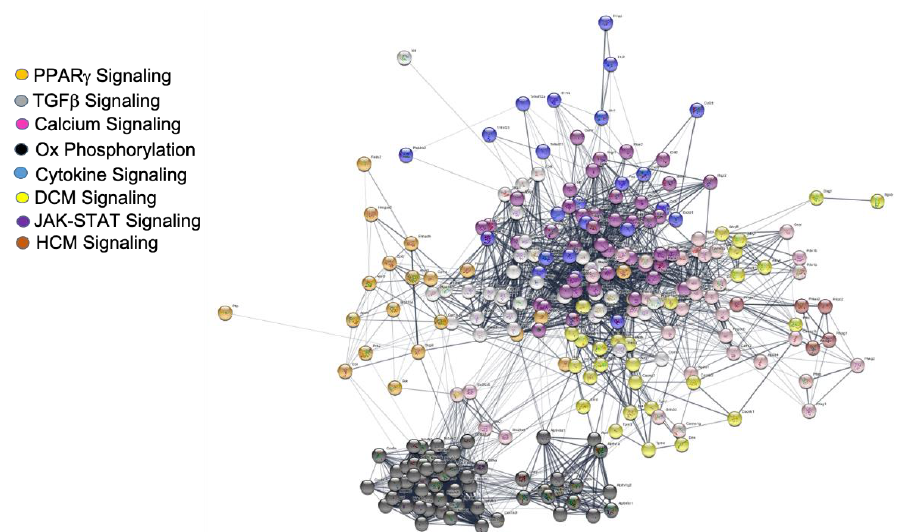
Figure 7. Network diagram associated with major pathways by GSEA altered in vitro. Color coding based on log 2 Fold Change with legend shown above. All genes were identified in KEGG pathways and are therefore associated with other genes in the STRING database.